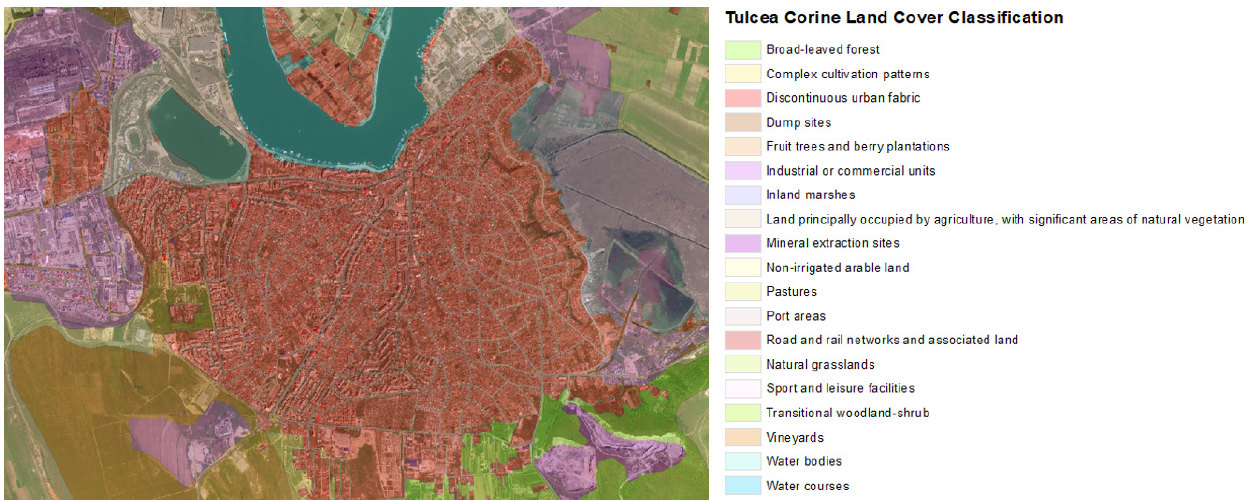
Figure 15. CLC classification of land cover for the Tulcea municipality.